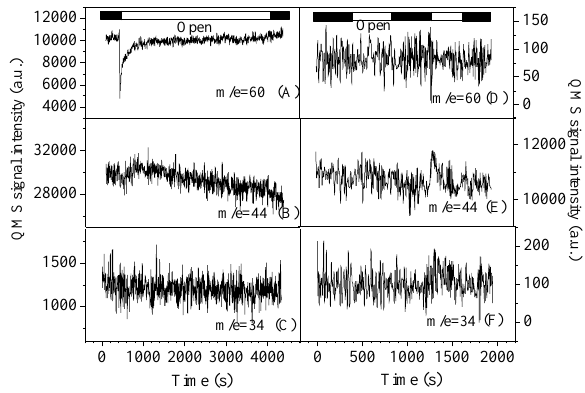
Fig. 3. The heterogeneous reaction of OCS on 200.9mg of ZnO at 300K (left side) and the in situ desorption of surface species in the end of uptake (right side). 662